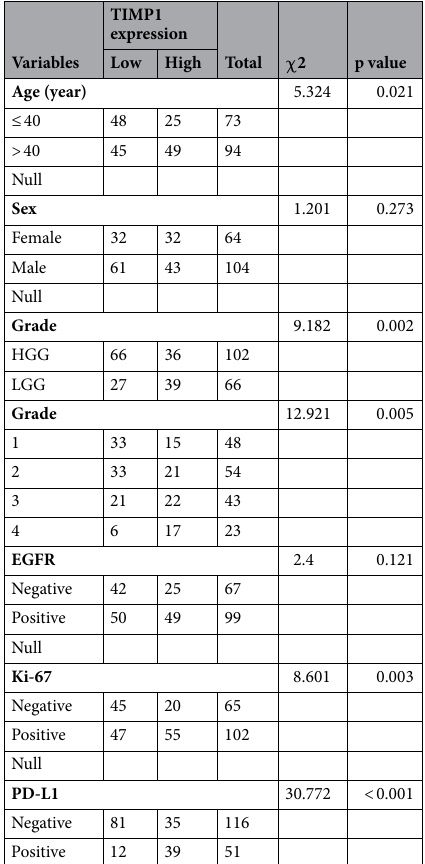
Table 3. The correlation of TIMP1 expression and clinicopathological characters among 180 glioma